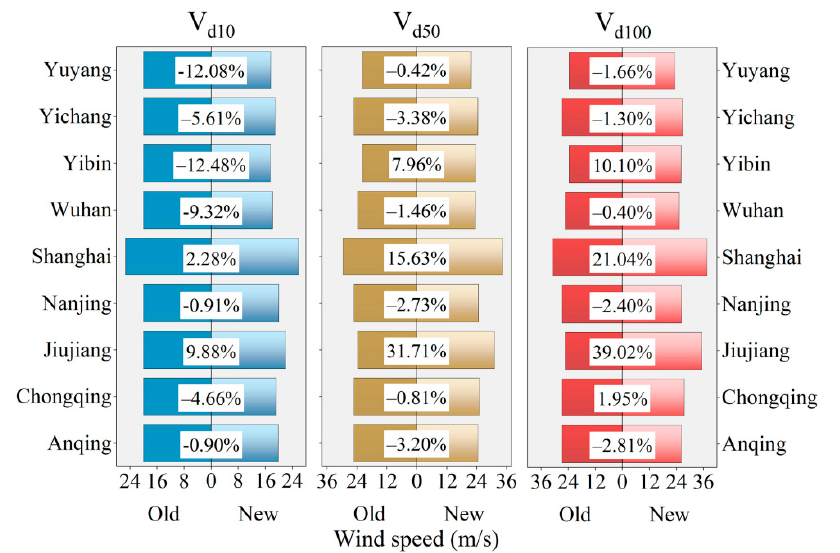
Figure 7. Comparison of 10/50/100 year design wind pressure values, Code design wind speed and updated design wind speed for each area of the YRIW in the Code. Note: old—indicates the design wind speed extracted from the Code; new—indicates the extrapolated design wind speed; E—percentage error.